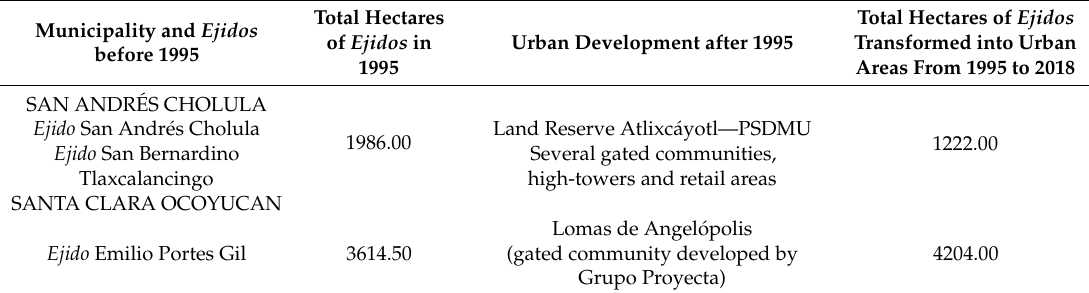
Table 3. Names and sizes of Ejidos in San Andr é s Cholula and Santa Clara Ocoyucan. Source: VII Ejidal